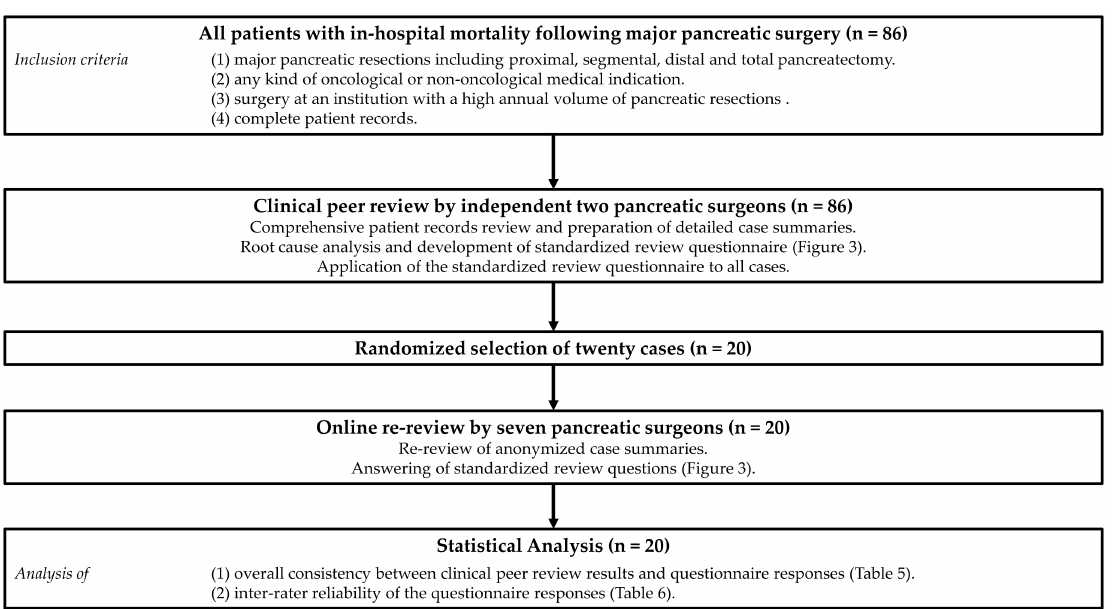
Figure 1. Flow chart showing the course of the